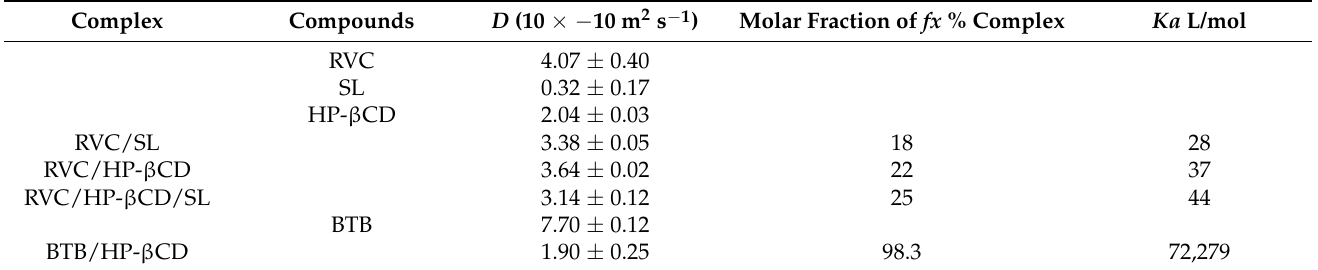
Figure 3. ( a ) Alternating topology for the BTB/HP- β CD; ( b ) RVC/HP- β CD complex. Table 2. Diffusion coefficients ( D ) of LA (BTB, RVC), HP- β CD and LA/HP- β CD, LA/HP- β CD/SL Table 2. Diffusion coefficients (D) of LA (BTB, RVC), HP- β CD and LA/HP- β CD, LA/HP- β CD/SL constant association (Ka) and molar fraction ( fx ). constant association ( Ka ) and molar fraction ( fx